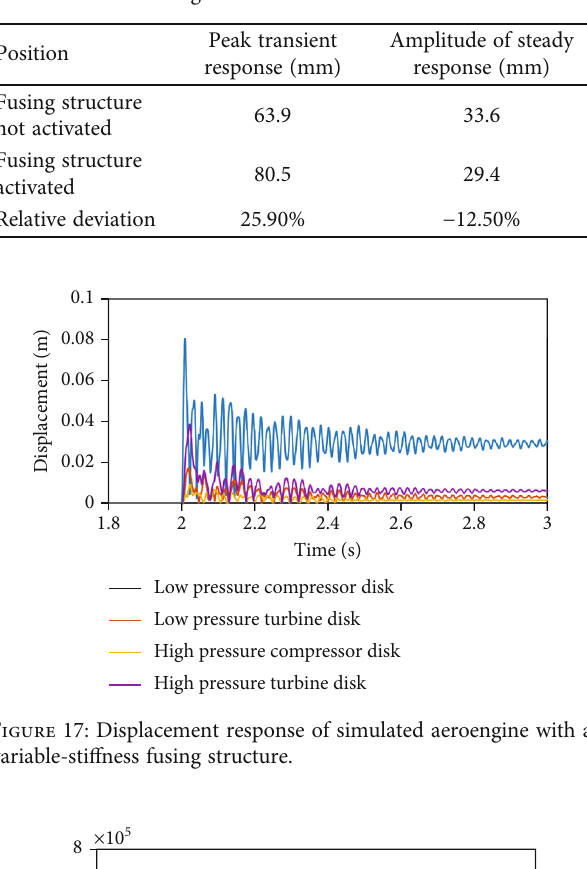
Table 7: Reaction force of the simulated engine system with a variable-sti ff ness fusing structure.